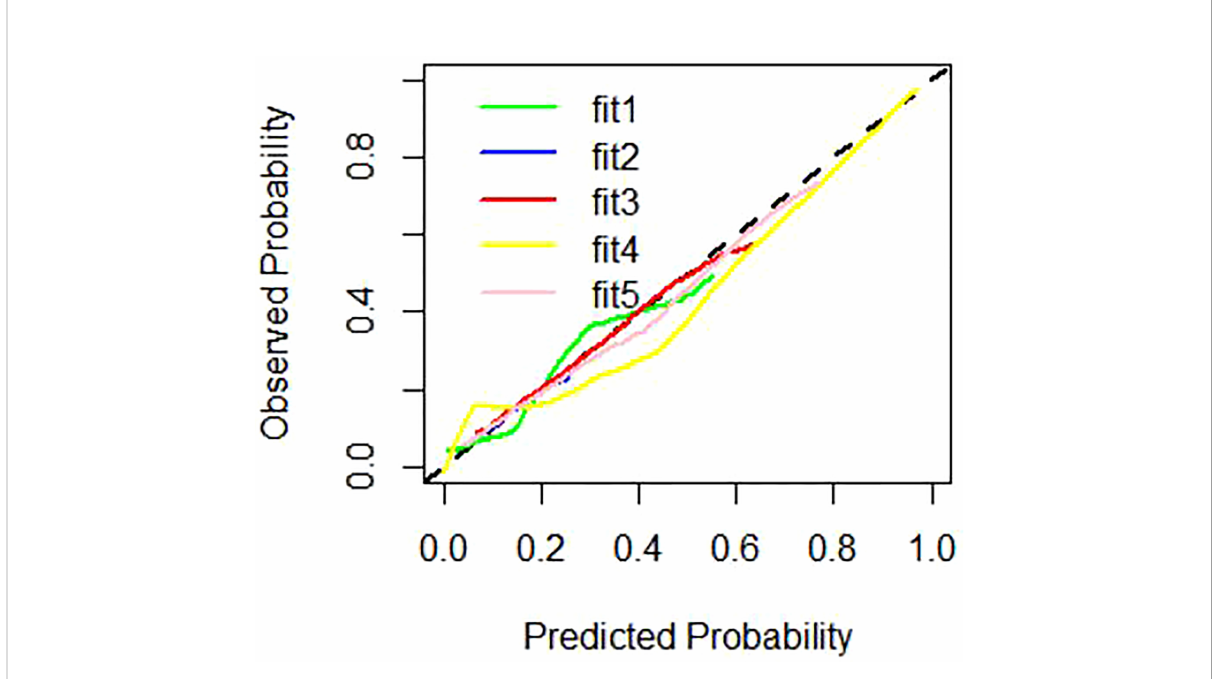
FIGURE 6 Calibration curves of different prediction models. Note: fi tl represent CT signs model for green line, fi t2 represent primary tumor texture model for blue line, fi t3 represent peritoneum texture model for red line, fi t4 represent Total Texture model for yellow line, fi t5 represent Total Texture+ CT signs model for pink